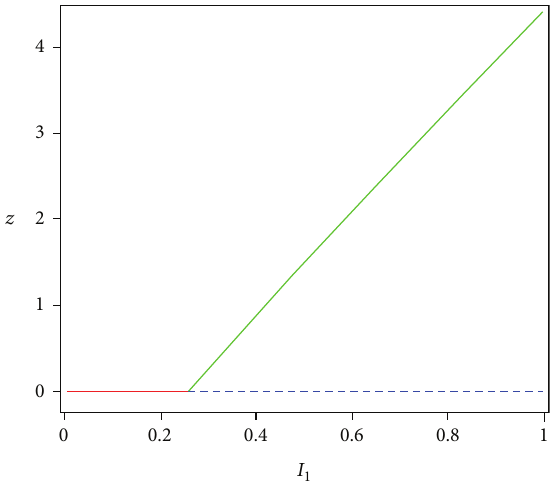
Figure 3: Bifurcation diagram of phytoplankton population with increasing input nitrogen concentration. The other parameters are the same as in Table 1. The red solid line indicates that 𝐸 1 exists and is globally asymptotically stable. The blue dashed line implies that 𝐸 1 exists, but is unstable. The green solid line indicates that and is globally asymptotically